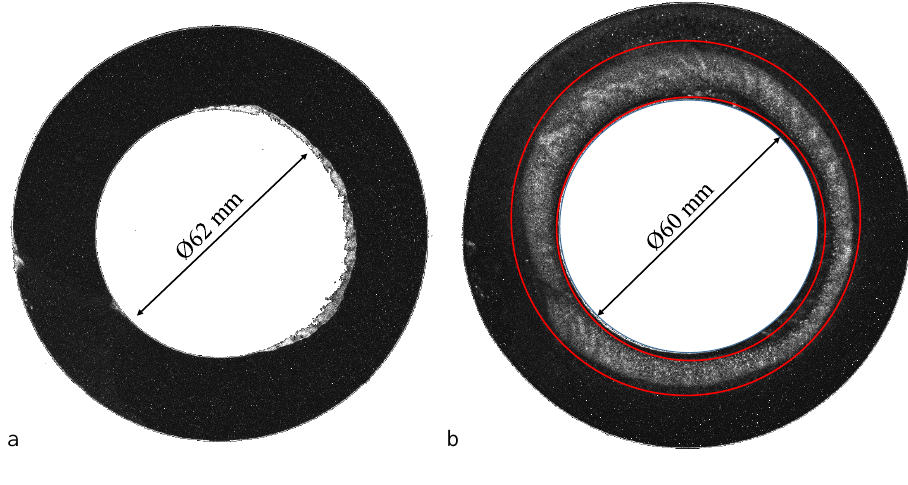
Figure 12. SAM measurments of semi-finished parts: ( a ) washer after welding and machining, ( b ) washer after welding and